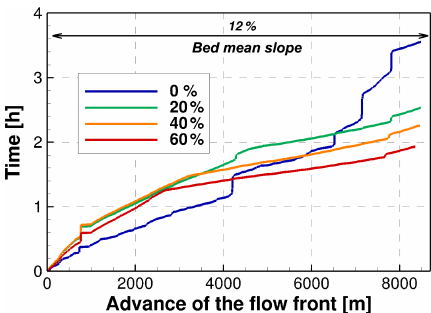
Figure 6. Location of the wave front in time for the Quebrada de Ramón stream downstream of the confluence considering four sed- iment concentrations in both